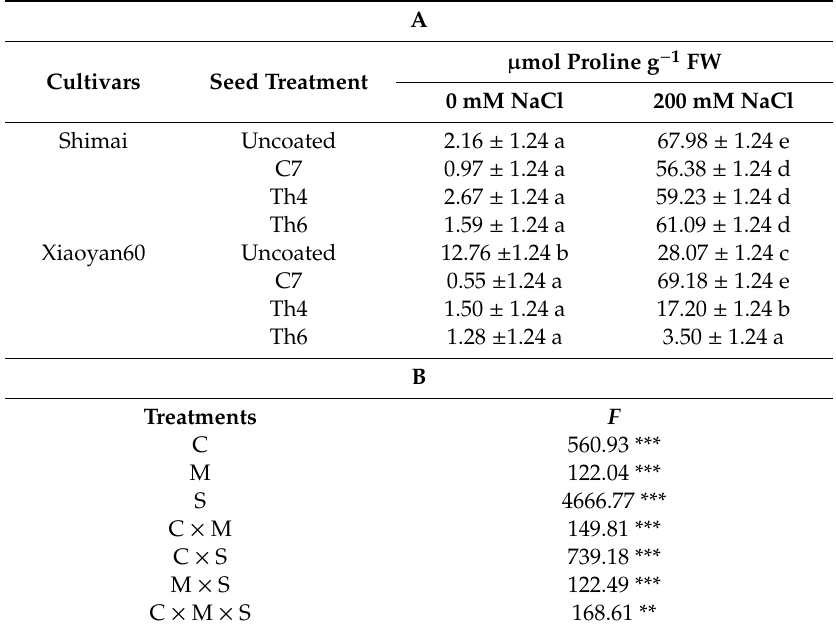
Table 2. Leaf proline contents ( µ mol proline g − 1 FW) of wheat cultivars (Shimai and Xiaoyan60) under microbial seed treatment and salt stress.